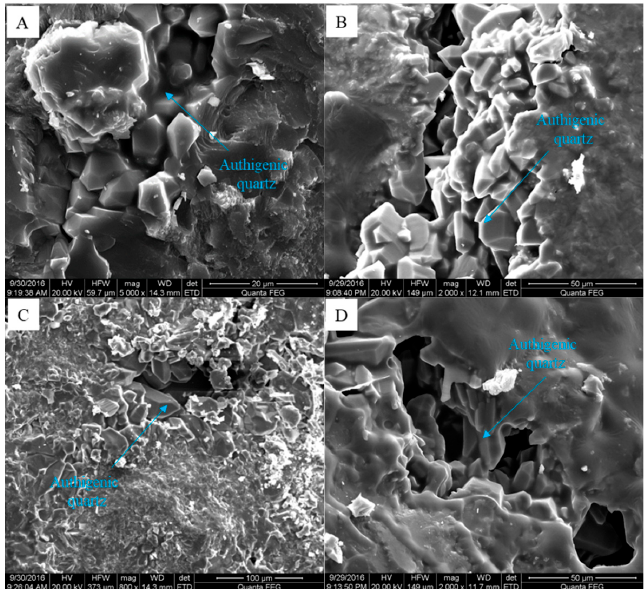
Figure 7. Scanning electron microscope of authigenic quartz in the pores, cavities, and cracks of Lucaogou Formation. ( A ) Transitional lithofacies, S1 well, 3147.64 m; ( B ) tuffaceous shale lithofacies, S2 well, 3348.08 m; ( C ) tuffaceous shale lithofacies, S3 well, 2815.21 m; ( D ) tuffaceous shale lithofacies, S4 well, 2601.81